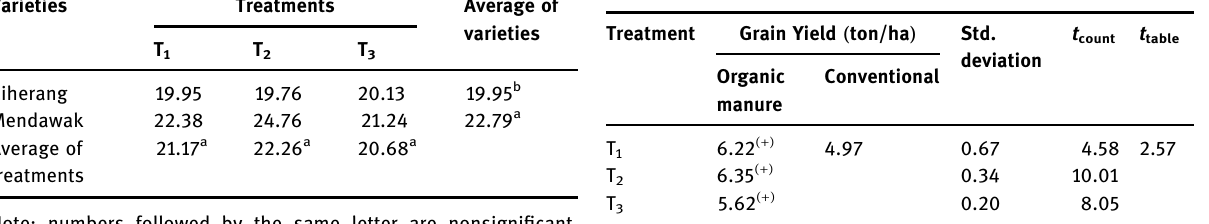
Varieties Treatments Average of